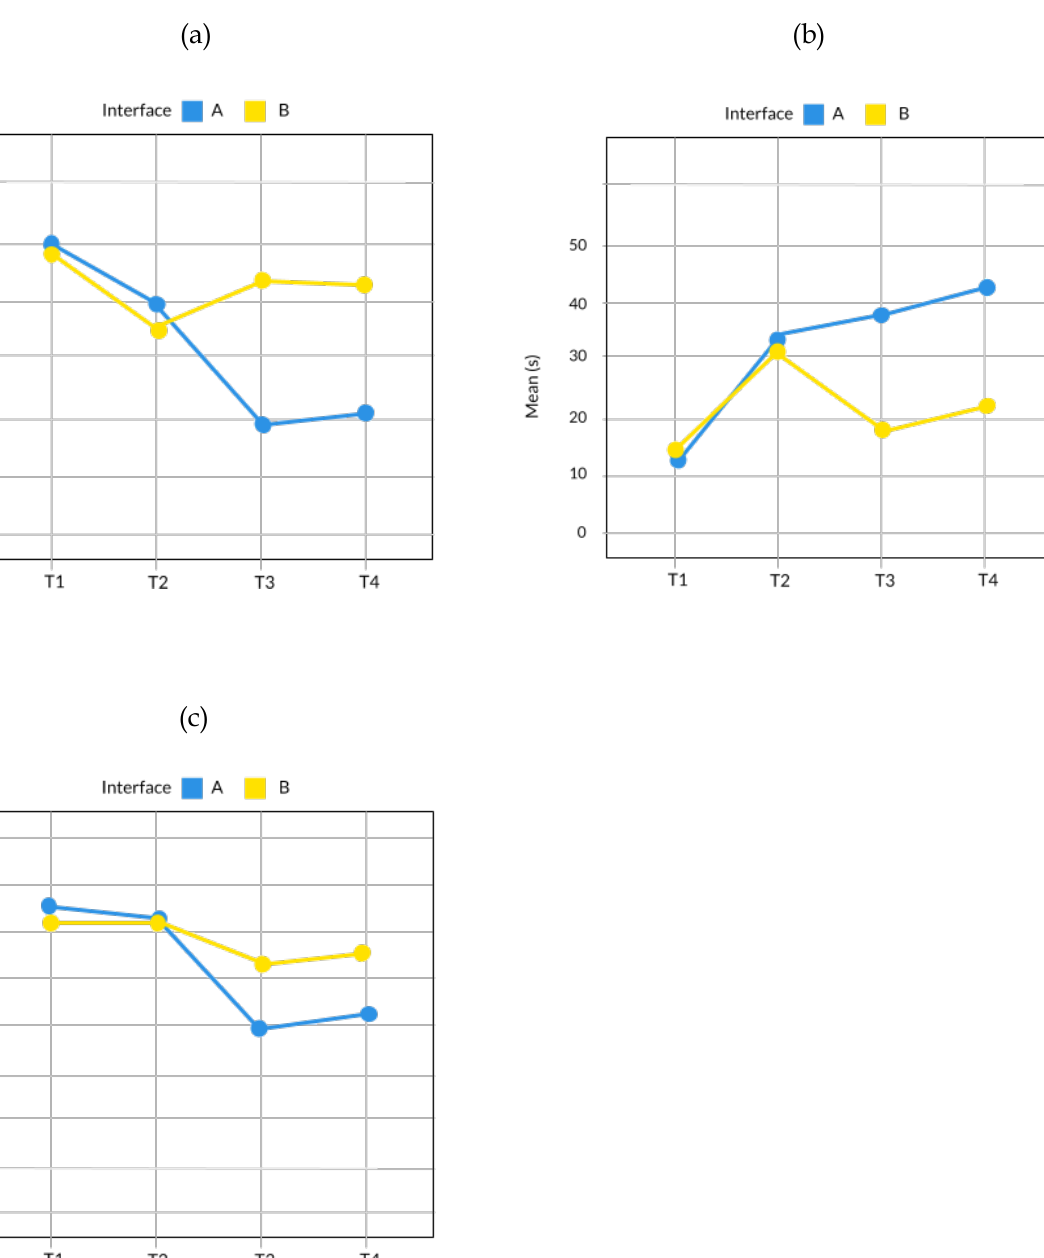
Figure 3: Line graph of the mean for (a) success rate, (b) completion time and (c) perceived satisfaction by interface (A: interface including a tree map versus B: interface including a stacked barchart) for each task (T1, T2: categorization tasks and T3, T4: comparison